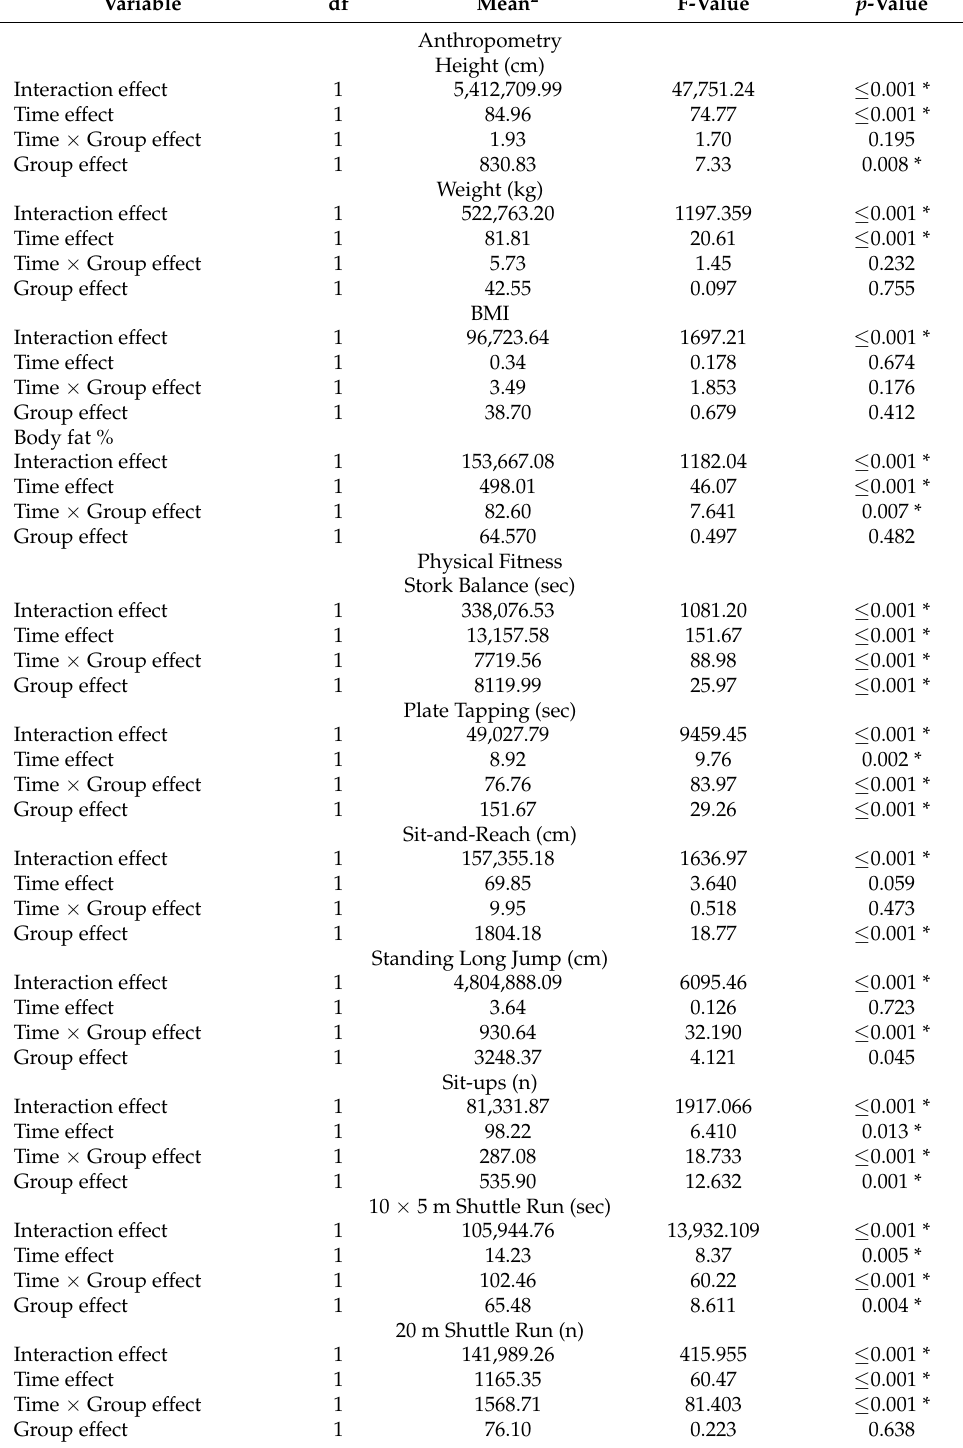
Table 4. Effect of the intervention program on the experimental- and control group regarding the anthropometric measurements and physical fitness